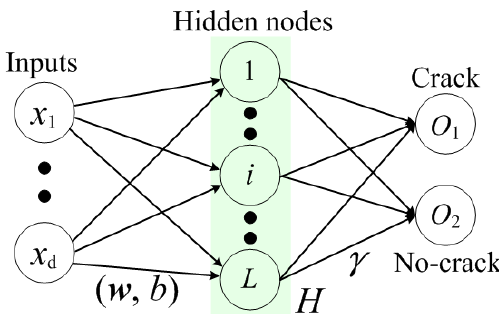
Figure 1. Representative framework of extreme learning machine (ELM)